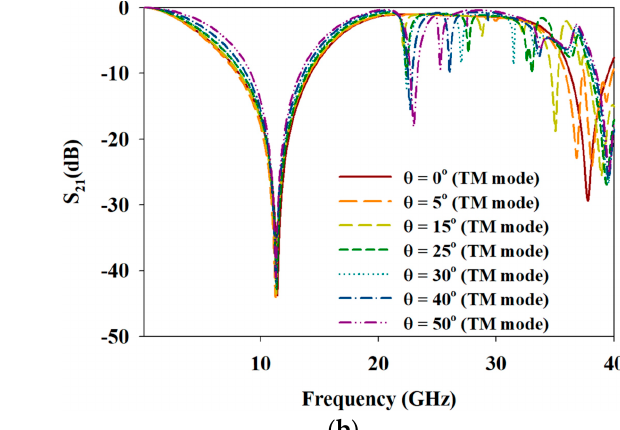
Figure 11. The simulated T (cid:3051)(cid:3051) and T (cid:3052)(cid:3051) of FSS 3 and transparent MFSS.